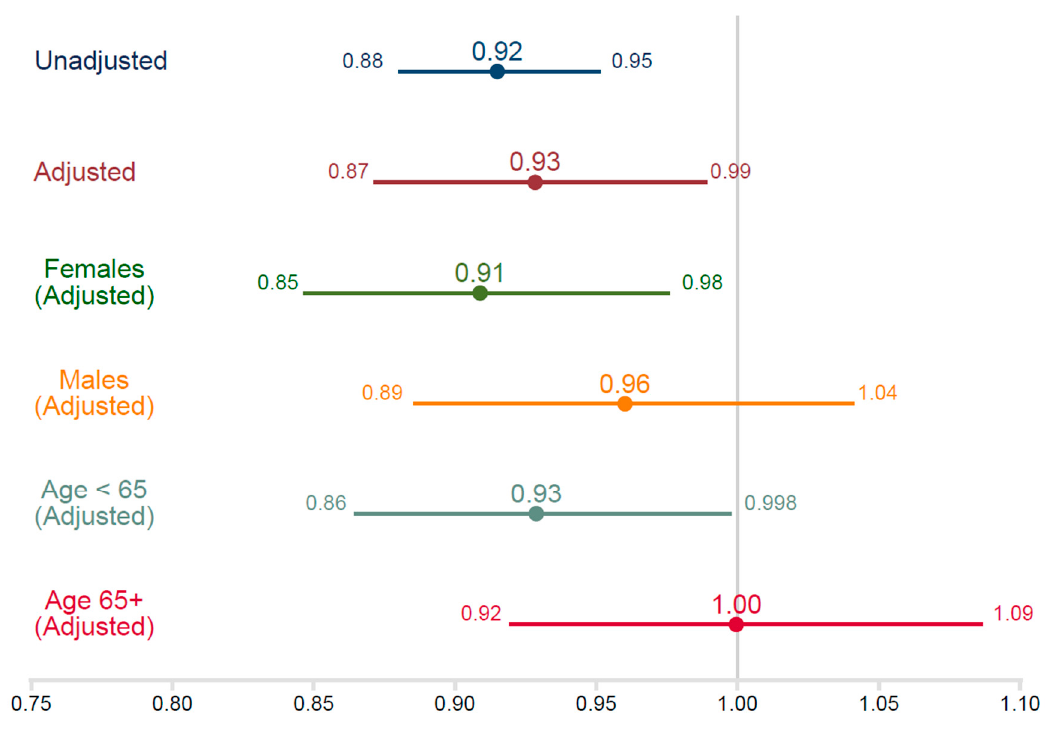
Figure 2. Odds ratios by logistic regression on chronic pain .